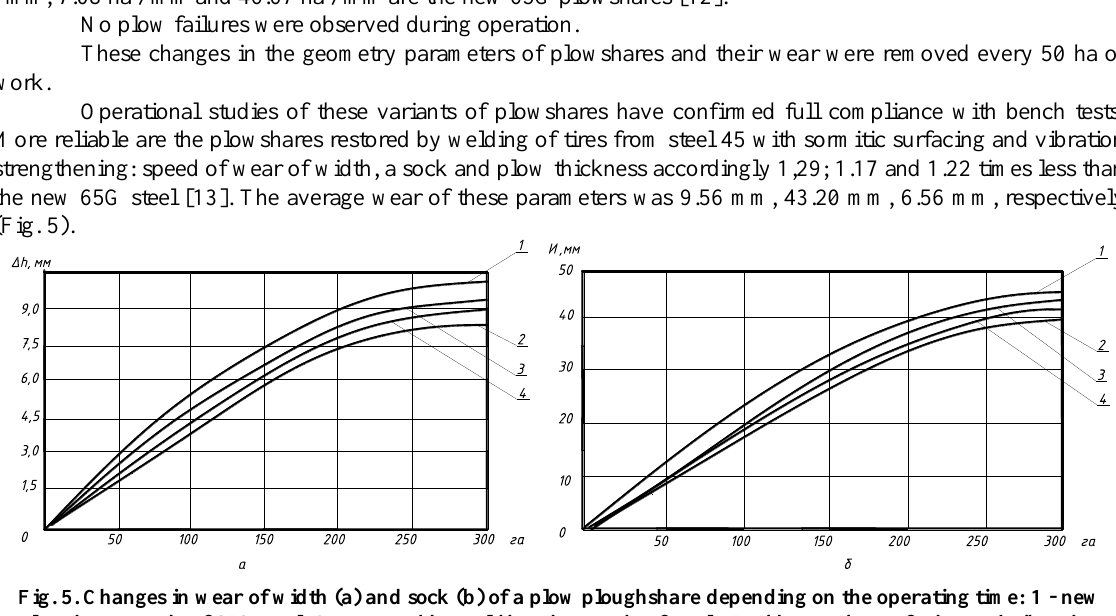
Fig. 4. Changes in residual stresses in depth depending on the method of plowing recovery, amplitude of oscillations of the processing tool and processing time t = 20 s: 1 - restored welded tires of steel 45 with surmaite surfacing and vibration hardening, 2 - new plowshares of steel L-53 subjected to vibration deformation, 3 - new plowshares made of steel 65G, strengthened by vibration deformation